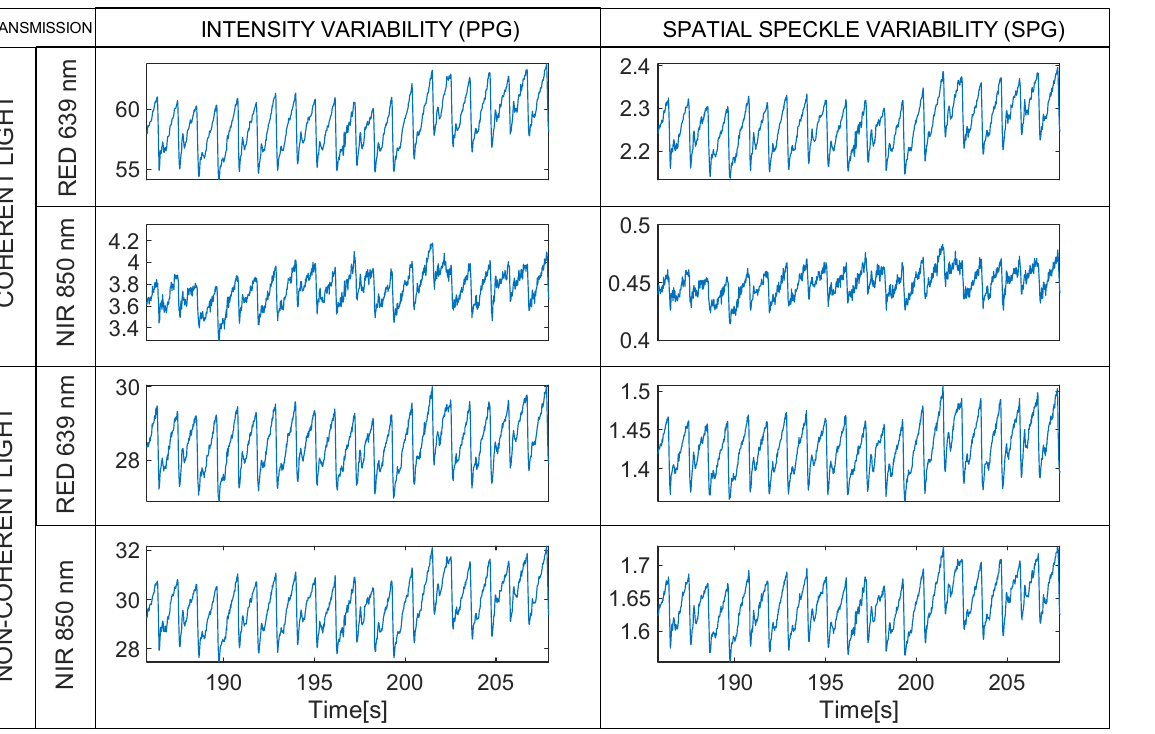
Figure 8. Transmissive mode. Synchronous rPPG ( left ) and rSPG ( right ) signals extracted from the 4 multiplexed light sources. Note the strong similarity in waveform morphology, as opposed to the reflective mode results in Figure 4. Note that raw waveforms are displayed without vertical inversion—PPG and SPG synchronous signals from a random subject with 1200 µ s integration time.